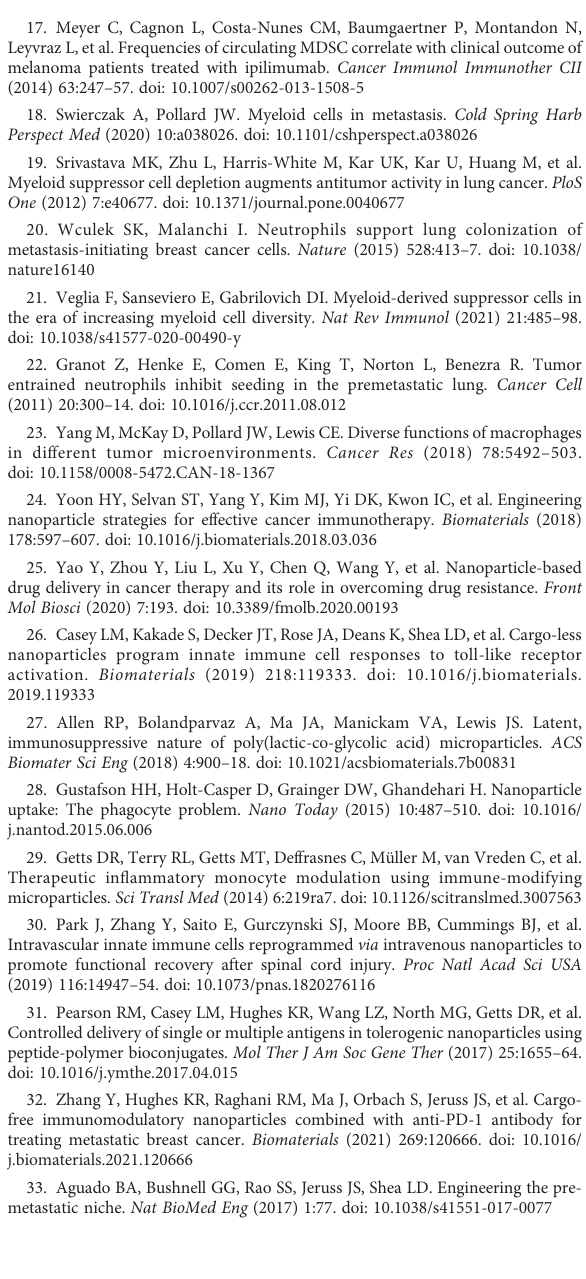
SUPPLEMENTARY FIGURE 4 NP administration upregulates activated phenotypes in T cells. (A) Histogram (left) and UMAP plot (right) of single cells at the lungs of NP or saline-treated mice (n=4 per group) identi fi ed as T cells in . (B) Marker genes used to identify T cell subsets. SUPPLEMENTARY TABLE 1 List of genes used to assign identities to single cell clusters in . SUPPLEMENTARY TABLE 2 List of genes used to classify (A) neutrophil, (B) monocyte, and (C) dendritic cell subsets in